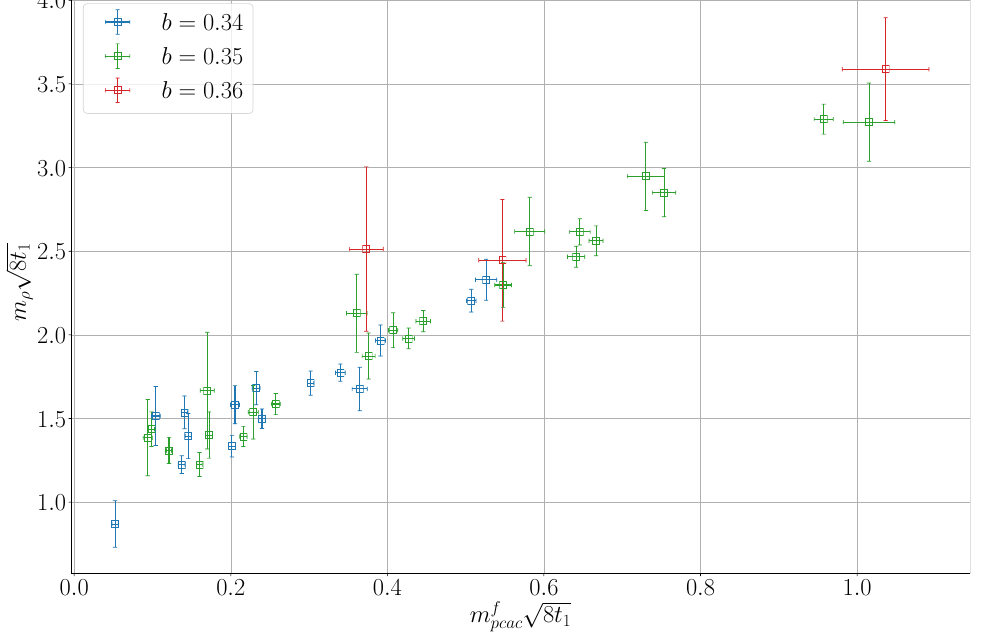
√ 8 t √ 8 t m f ρ 1 on 1 for all the data samples included in table pcac